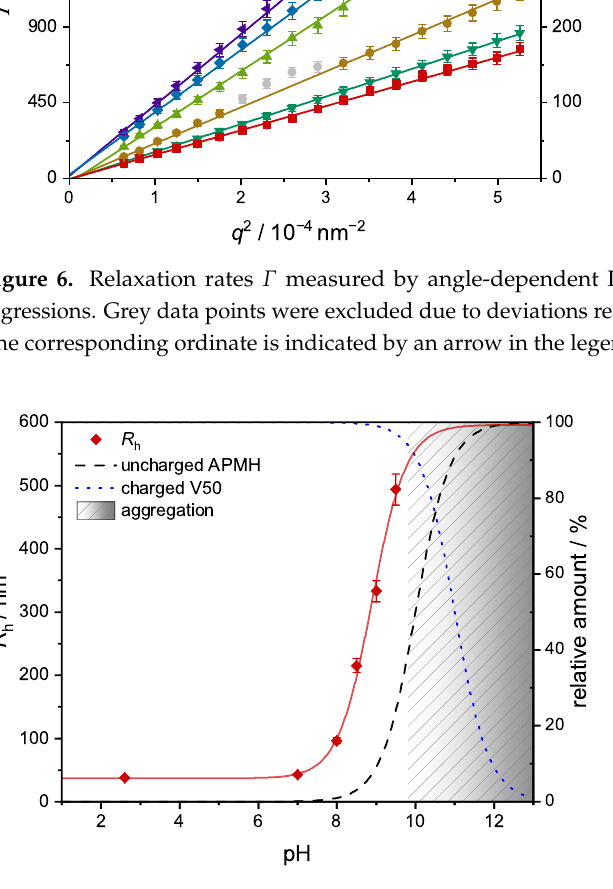
Figure 7. Dependence of R h on the reaction pH with a modified H ENDERSON -H ASSELBALCH adjustment after Equation (4). Additionally shown are the protonation states of APMH and V50 for p K a -values of 10 and 11 [61], respectively. The region above pH = 9.5 is not accessible due to aggregation during